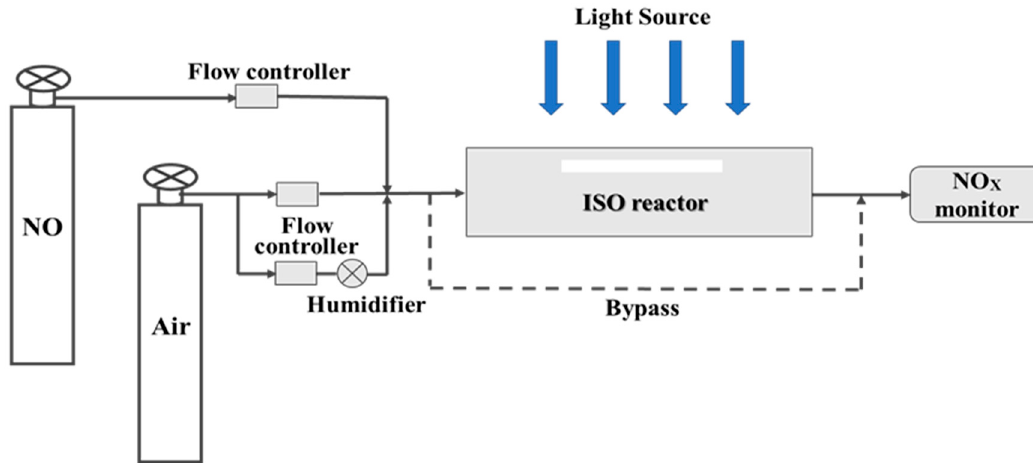
Figure 10. Schematic diagram of photocatalytic reaction for NOx degradation.